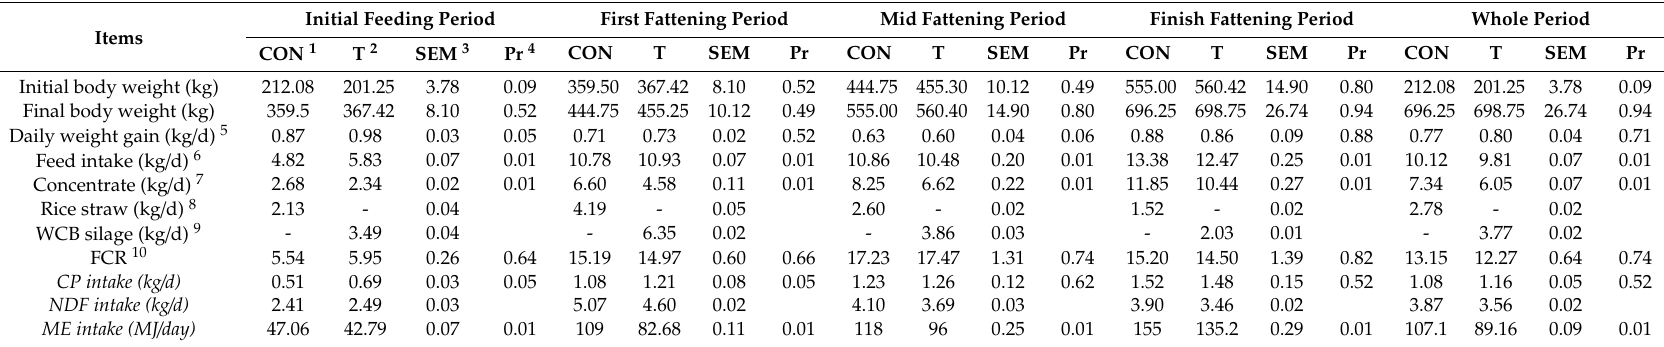
Table 3. E ff ects of feeding whole-crop barley silage (WCBS) / concentrate on growth performance and feed intake for steers during di ff erent fattening